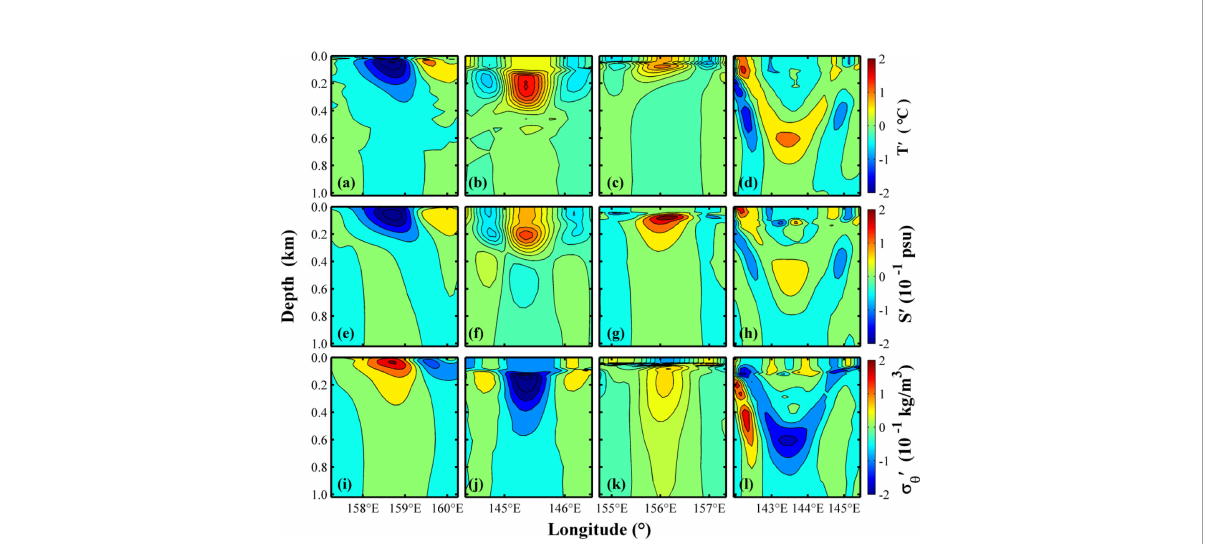
FIGURE 4 Vertical cross-sections of temperature anomaly (A – D) , salinity anomaly (E – H) , and potential density anomaly (I – L) are modulated by the four eddy cases. (A, E, I) correspond to the cyclonic cold-core eddy case, (B, F, J) correspond to the anticyclonic warm-core eddy case, (C, G, K) corresponds to the cyclonic warm-core eddy case, and (D, H, L) correspond to the anticyclonic cold-core eddy case. Shading in (A – D) , (E – H) , and (I – L) indicate temperature (units: °C), salinity (units: 10 -1 psu), and potential density anomalies (units: 10 -1 kg/m 3 ),